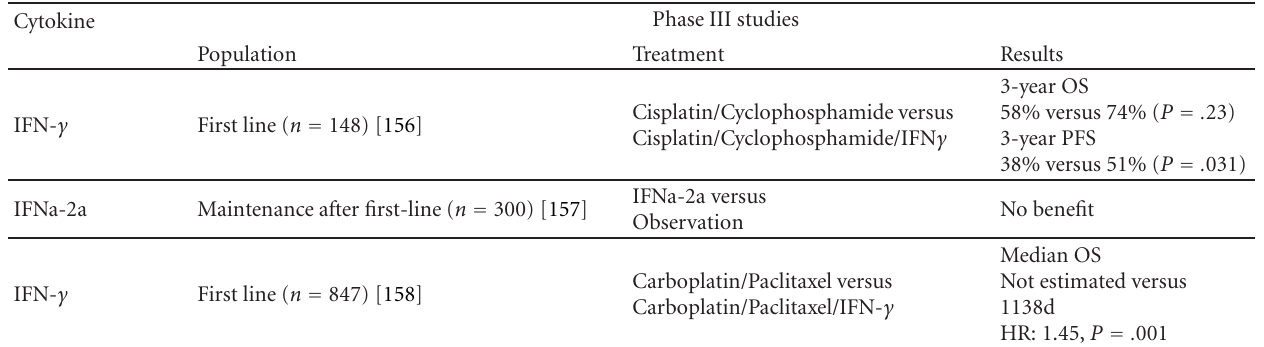
Table 2: Selected clinical studies of cytokines for the treatment of ovarian